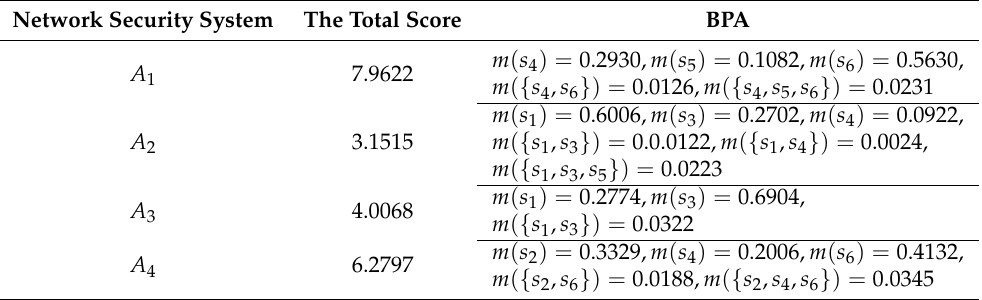
Table 19. The evaluation results by using the assessment approach in